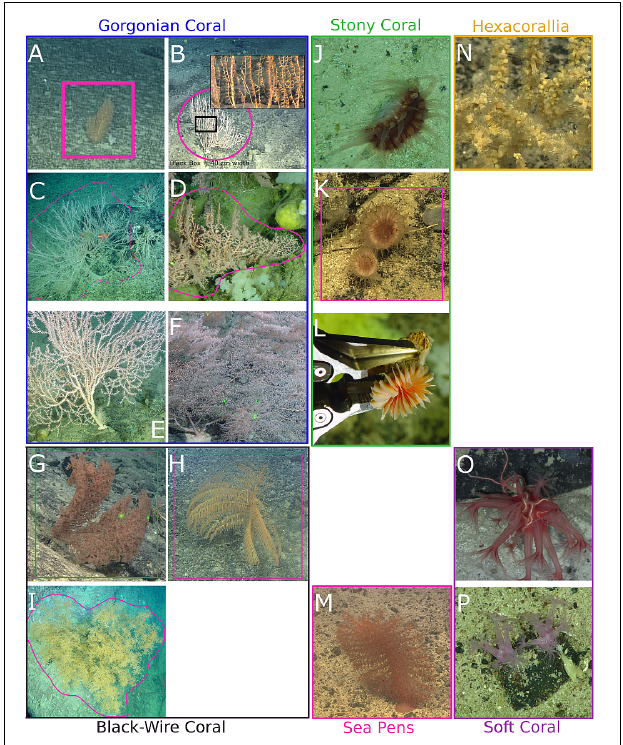
FIGURE 11 | Cold-water corals observed on the Orphan Seamount and Orphan Knoll. ‘Gorgonian’ corals: (top left): (A) Acanella arbuscula . (B) Isididae. (C) Keratoisidinae. (D) Corallium sp., probably C. niobe (E) Paramuricea sp. (F) Chrysogorgia sp. Black-wire coral (bottom-left): (G) Antipatharia indet., (H) Bathypathes sp., (I) Stauropathes sp., Stony coral (green box): (J) Flabellum sp., (K) Caryophyllia ambrosia , (L) Desmophyllum dianthus . Sea Pens (pink box): (M) various sea pen species, the most common was Pennatula spp., as shown here, Hexacorallia (top right): (N) Zoantharia, and Soft corals (bottom-right): (O) Anthomastus spp., (P) Nephtheidae. All corals identified visually, hence morphospecies, except for corals shown in (C,D,F,H–L) , for which voucher specimens were